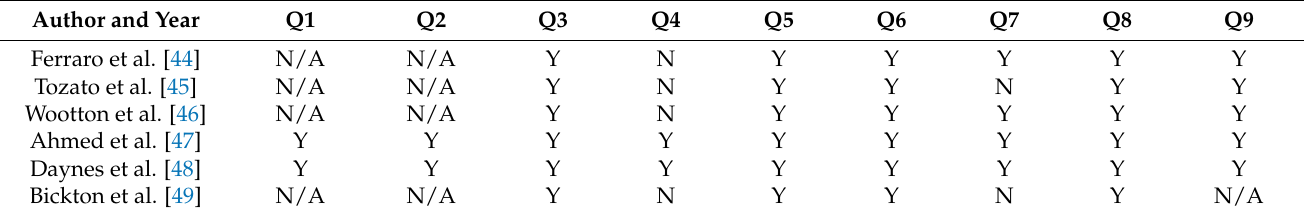
Table 5. Joanna Briggs Institute Critical Appraisal Checklist for Quasi-Experimental Studies (non- randomized experimental studies).